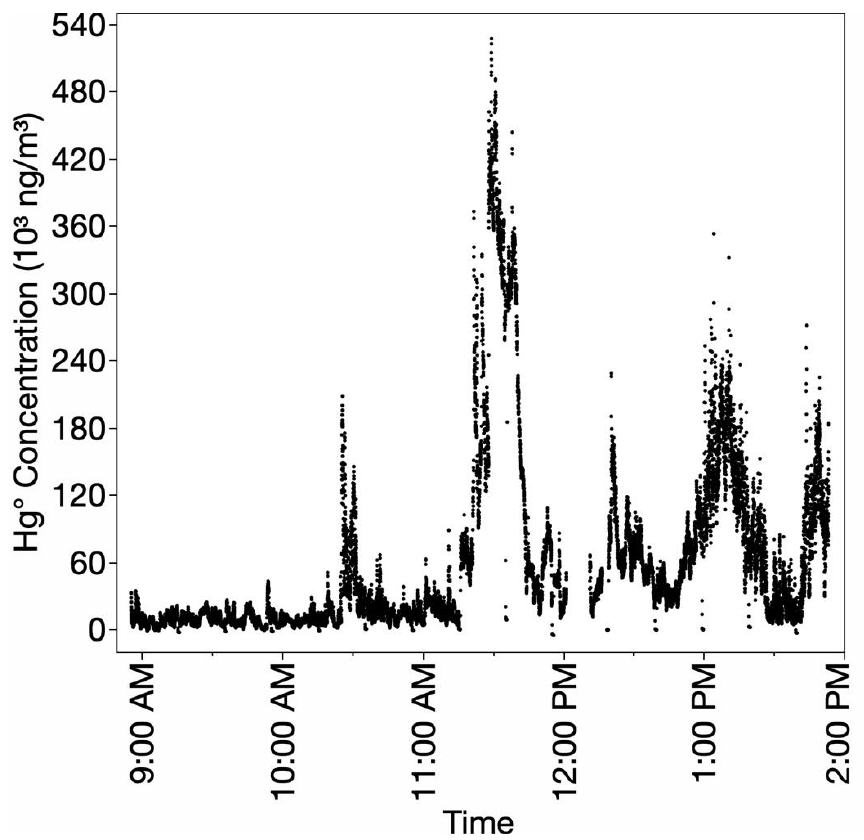
Figure 5. Hg 0 concentrations recorded at a gold shop in Bartica, Guyana.